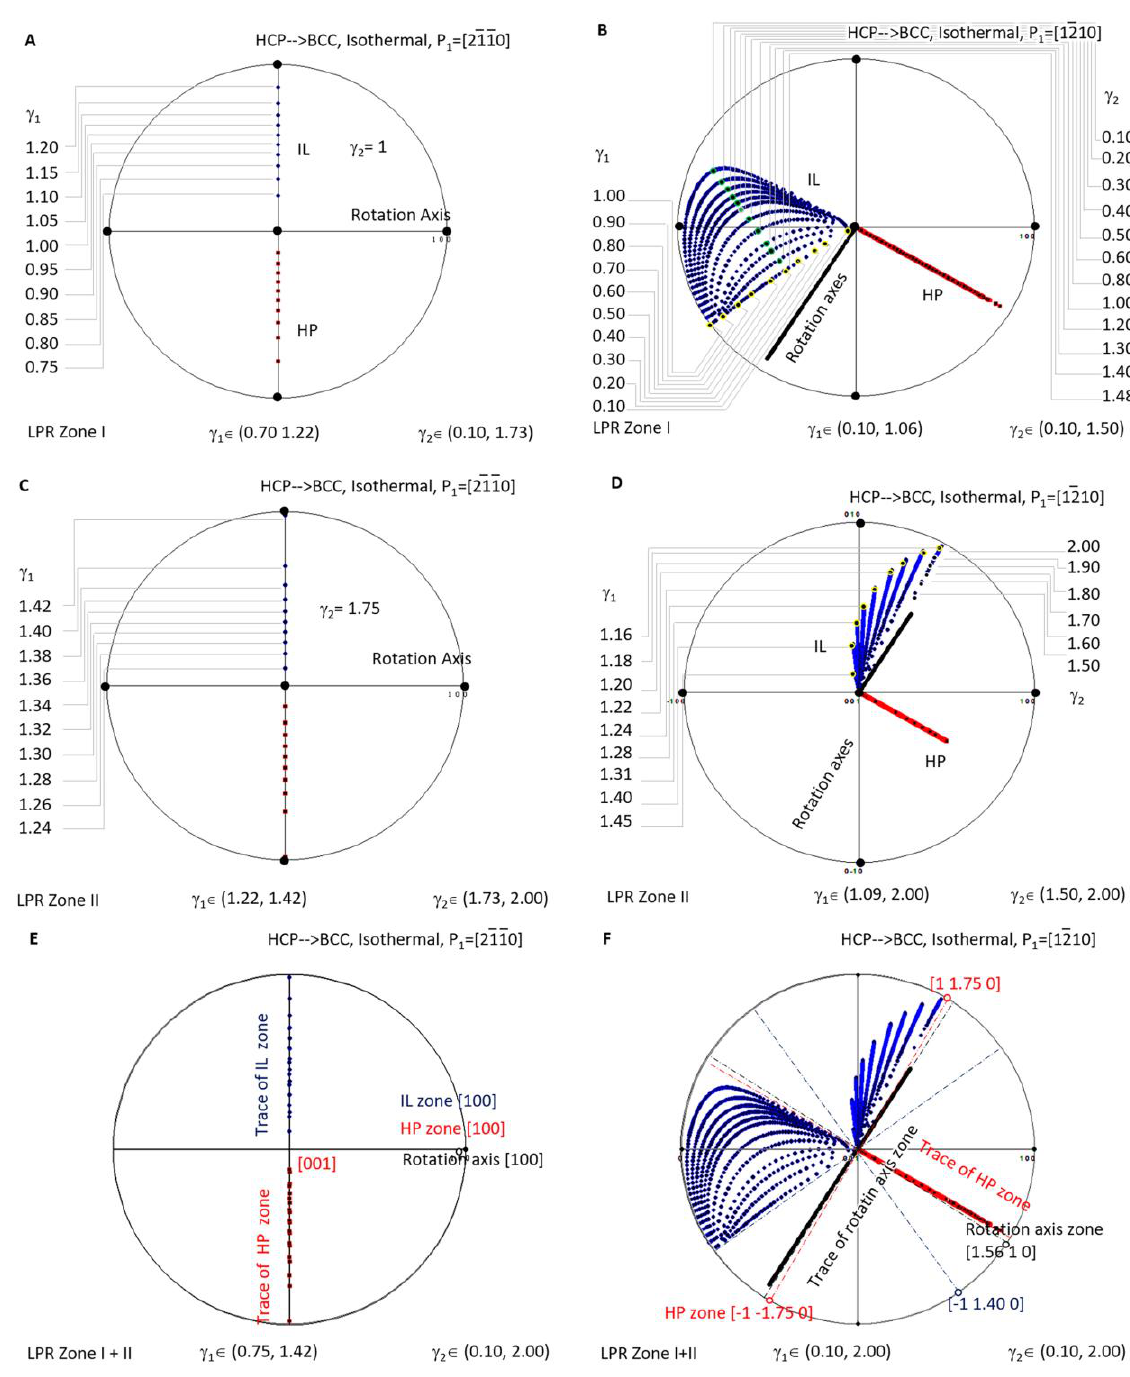
Figure 7. Stereographic project showing calculated crystallographic features (HP and IL) of HCP-to-BCC precipitation under the condition of non-inclined vector P 1 parallel to HCP Burgers vector. ( A ) Isothermal LPR Zone I for [2110] . ( B ) Isothermal LPR Zone II for [2110] . ( C ) Isothermal LPR Zone I for [1210] . ( D ) Isothermal LPR Zone II for [1210] . ( E ) Overlapping of two LPR zones for [2110] . ( F ) Overlapping of two LPR zones for [1210] . When overlapping the two LPR zones of the case P 1 // [2110] as shown in Figure 7E, it is found that all the rotation axes are parallel to [100], and all the HP poles belong to the same zone [100]. At the same time, IL points lie on the trace of [100]. The case P 1 // [1210] , as shown in Figure 7F, shows a complicated distribution pattern of IL. However, that of